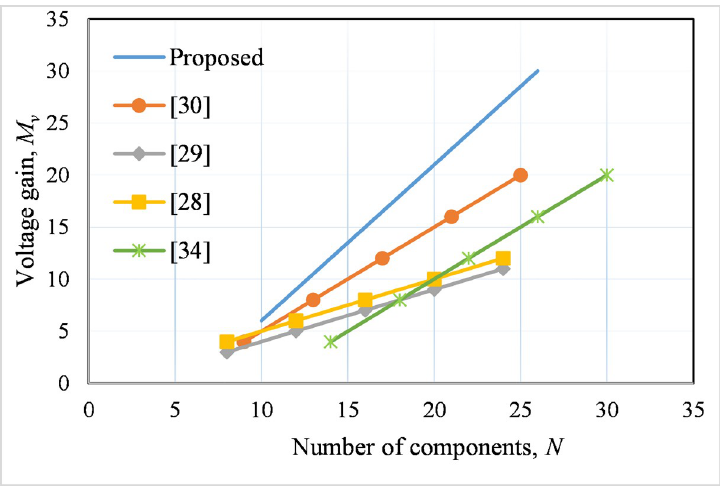
Fig 8. Voltage gain at different component numbersfor duty ratio, d = 0.5, V o = 380V for the developed converter and other topologies.